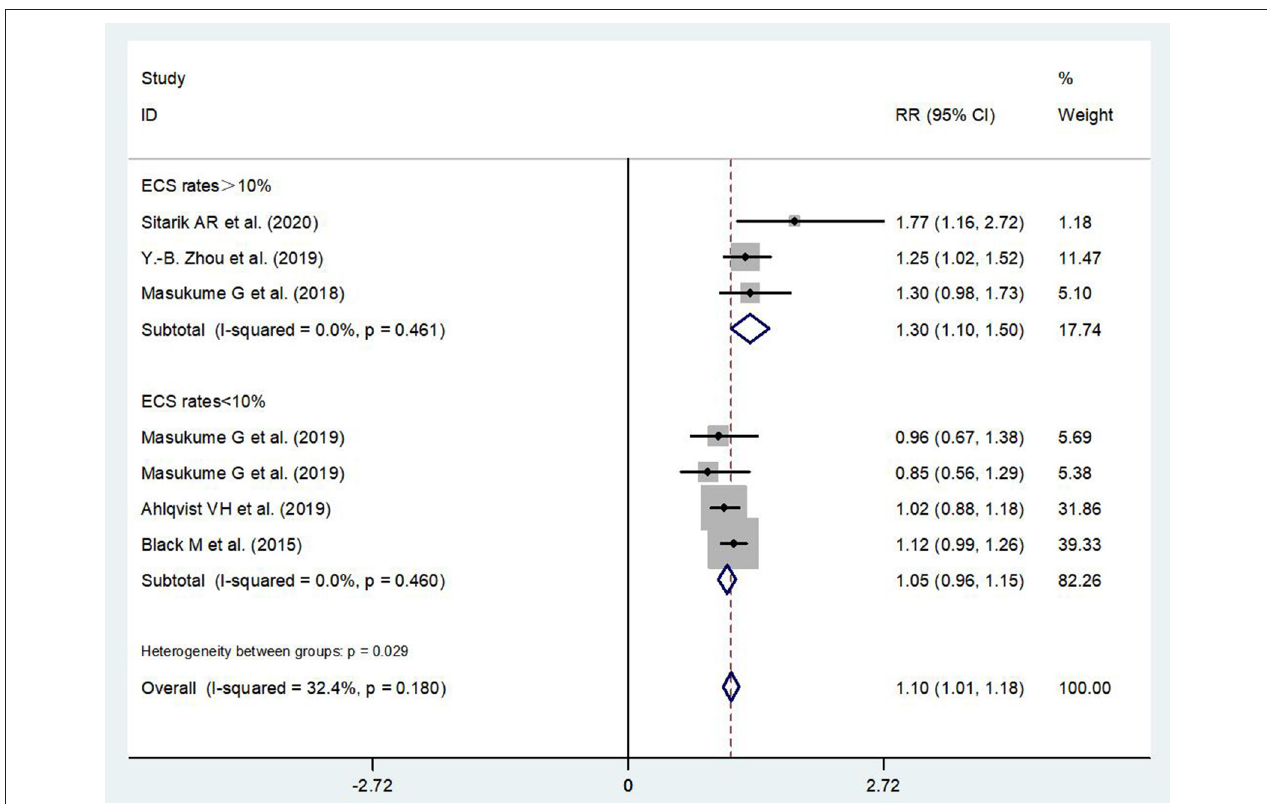
FIGURE 6 | Subgroup analysis on the association between ECS and children’s obesity stratified by ECS rate.